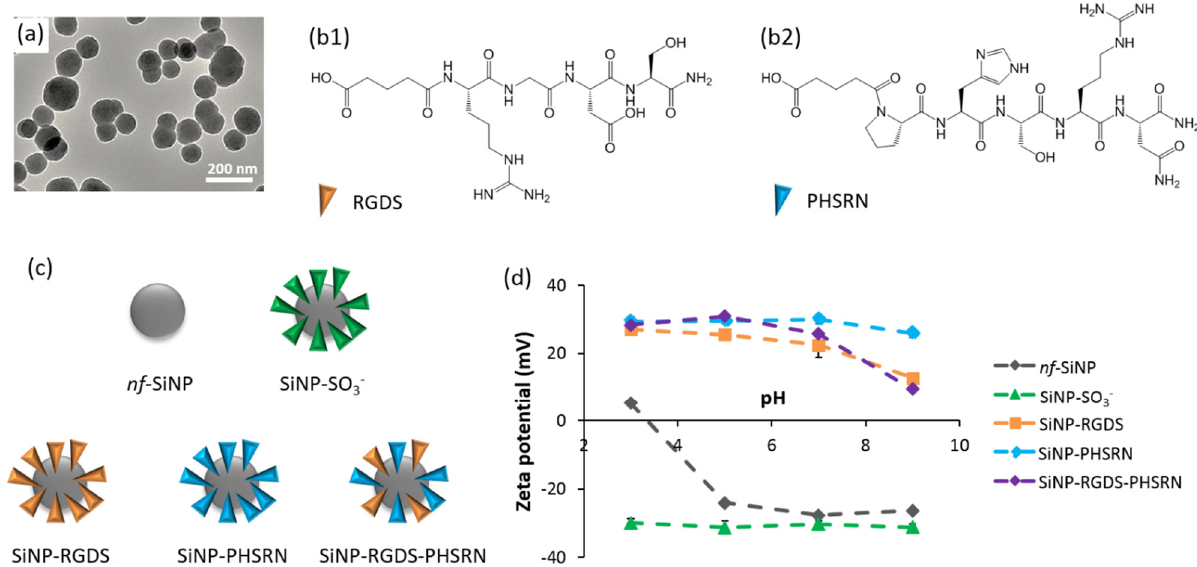
Figure 3. ( a ) TEM image of nf -SiNP. ( b1 , b2 ) Molecular structures of the RGDS and PHSRN peptides. ( c ) Scheme of the different SiNP surface chemistries. ( d ) Characterization of SiNPs by zeta potential measurements.